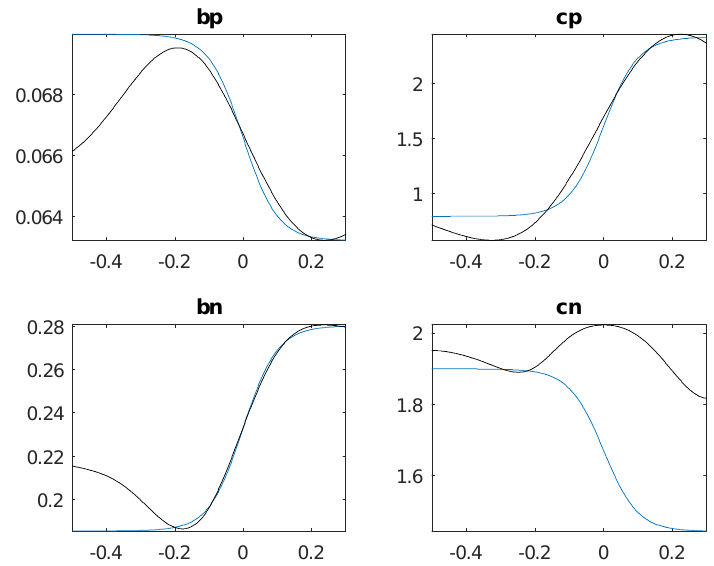
Figure 8. The true logistic curve functional dependence is presented in blue. The calibrated dependence Figure 8: The true logistic curve functional dependence is presented in blue. The as estimated from the implied option prices is presented in black. calibrated dependence as estimated from the implied option prices is presented in black.